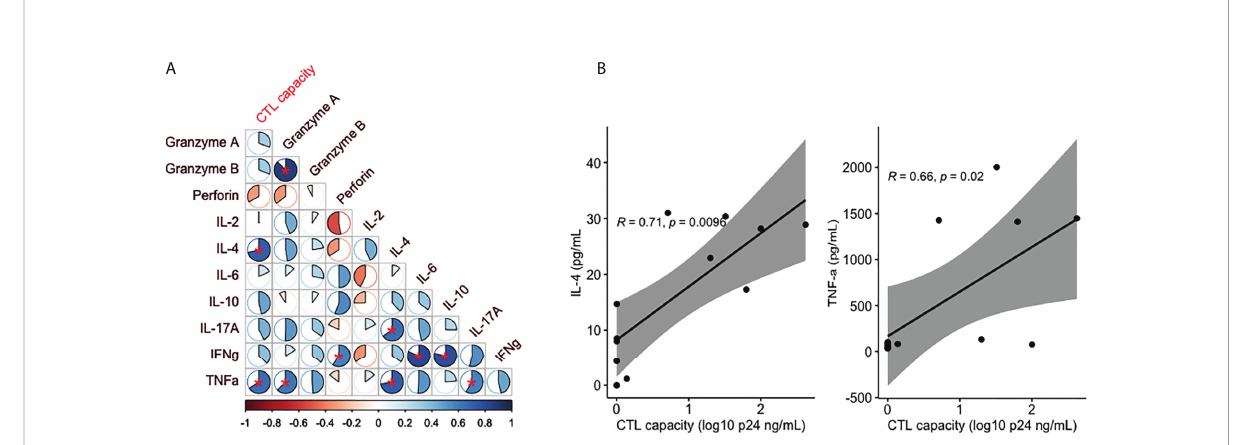
FIGURE 6 (A) Heatmap of correlations between cytolytic activity, cytokines and cytotoxicity markers. The pie charts depict the magnitude of each individual Spearman Rho correlation coef fi cient in a color gradient from red (Rho -1) to blue (Rho +1). Correlations with a P<0.05 are marked with a red asterisk. (B) Correlation analysis for those variables signi fi cantly associated with CTL